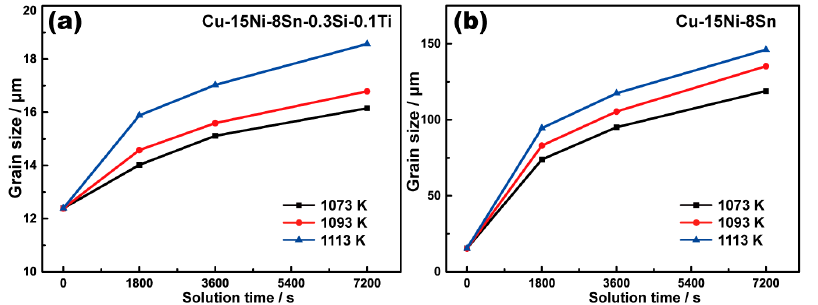
Figure 3. Average grain sizes of the Cu-15Ni-8Sn-0.3Si-0.1Ti ( a ) and Cu-15Ni-8Sn ( b ) alloys after different solution processes. Table 2. Grain growth factor ( G f ), grain grow exponent ( n ), and activation energy ( Q ) for the studied alloys with a solution process of 2 h.